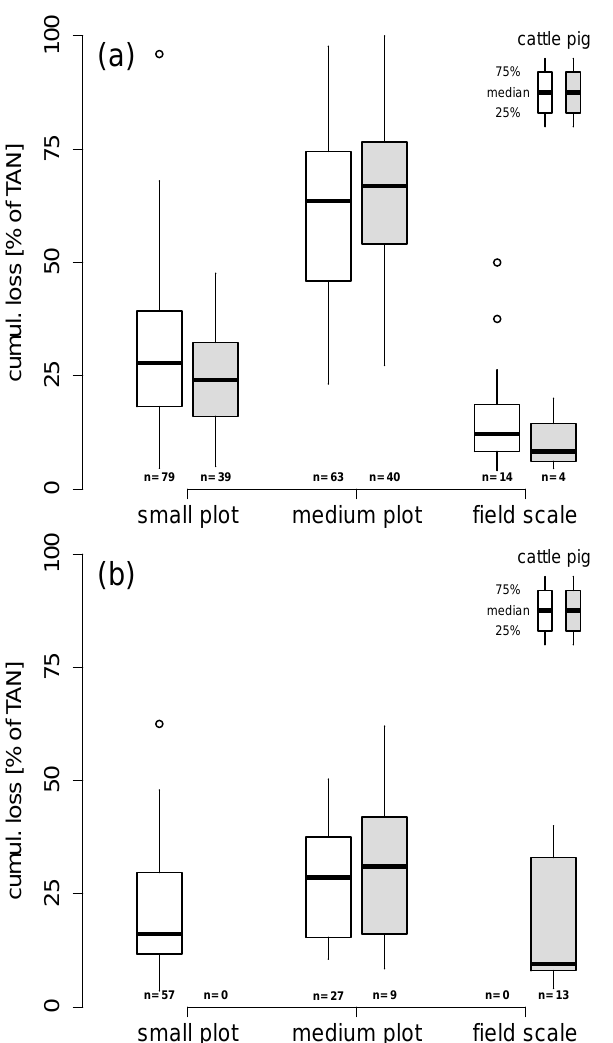
Fig. 2. Reported NH 3 EFs for cattle and pig slurry depending on the measurement scale for (a) splash plate spreading and (b) band (near-surface) spreading; small plot scale: < 10m 2 , medium plot scale:mostly circles with radius of 20 to 50m, field scale: typi- cally > 5000m 2 .